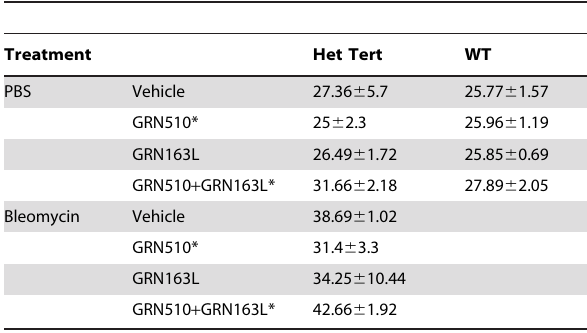
Table 1. Evaluation of collagen content in lung tissues (Ug of collagen/mg of tissue).